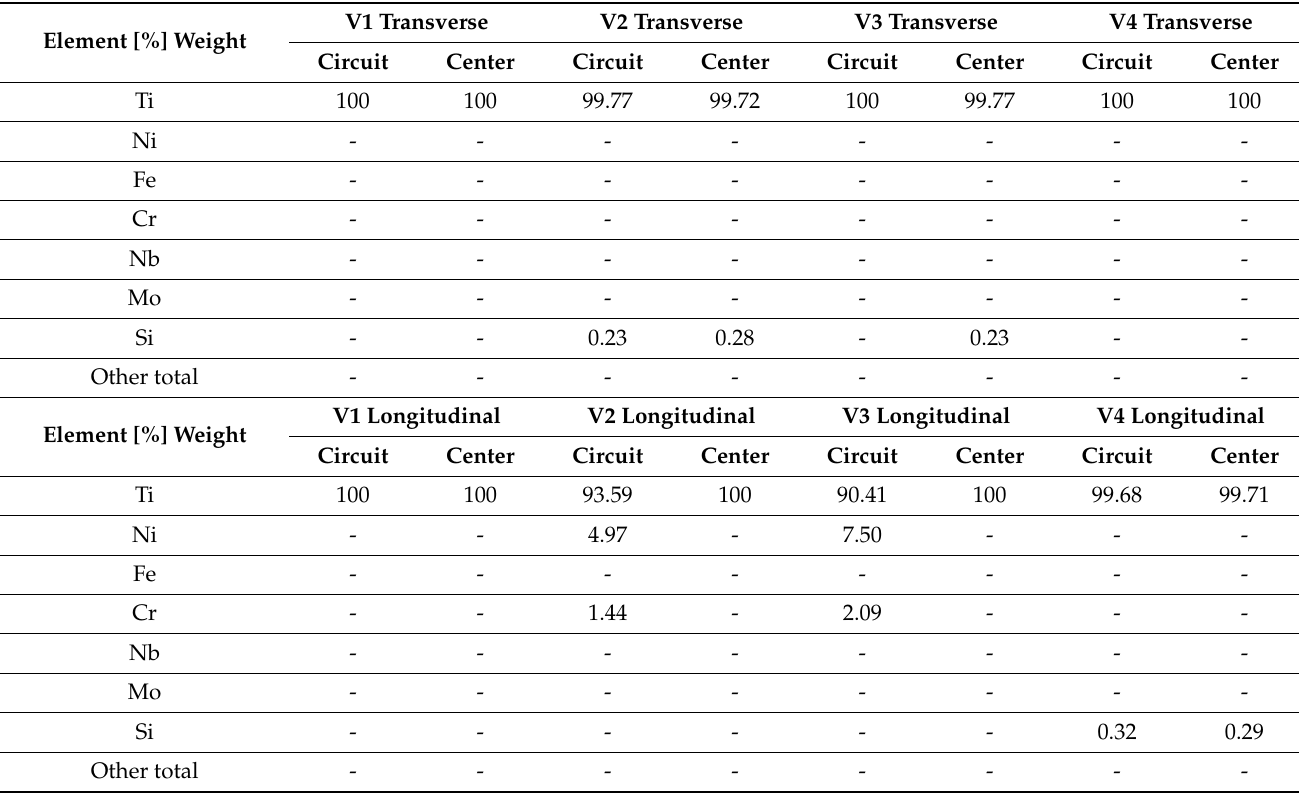
Table 6. Results of the chemical composition obtained using SEM-EDS technique. Samples V1–V4 analyzed on the transverse section and on the longitudinal section in different areas (circuit, center). Error of measurements: ± 0.66%